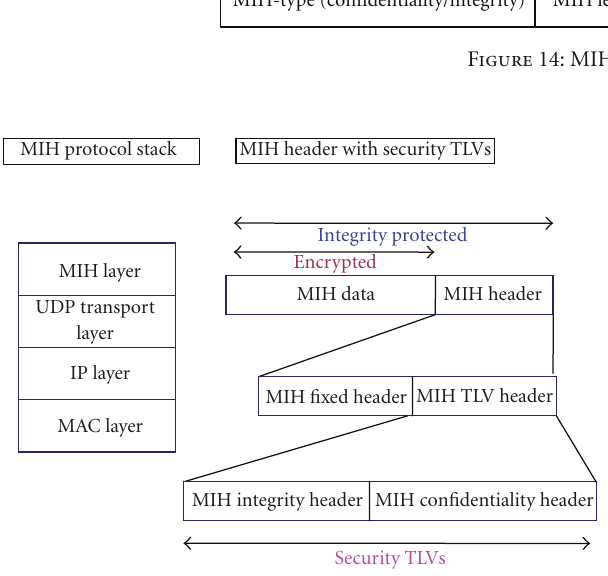
Figure 15: MIH with security TLV.